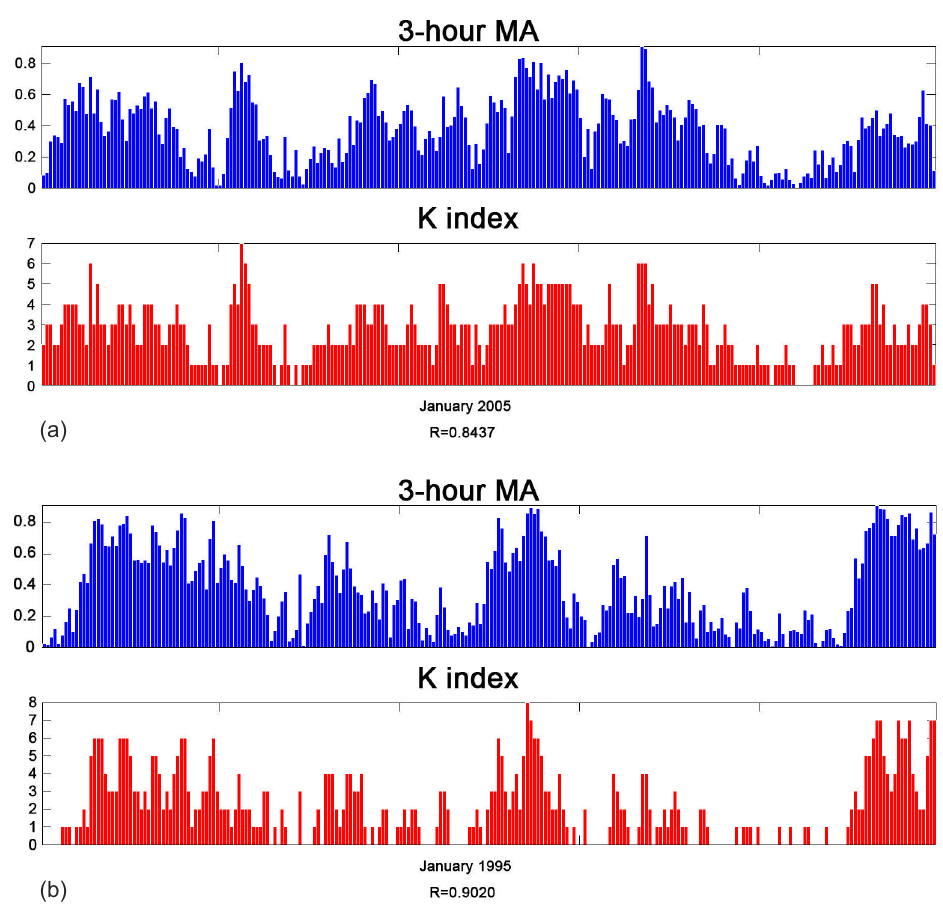
Figure 2. Comparison between the 3-hourly averaged minute values of MA and the regional 3-hour K index values K ( t ) for the disturbed mag- netic records of the north component: Chambon-la-Forêt observatory (CLF), January 2005 (correlation coefficient R is 0.84) (a); Sodankyla observatory (SOD), January 1995 (correlation coefficient R is 0.90)